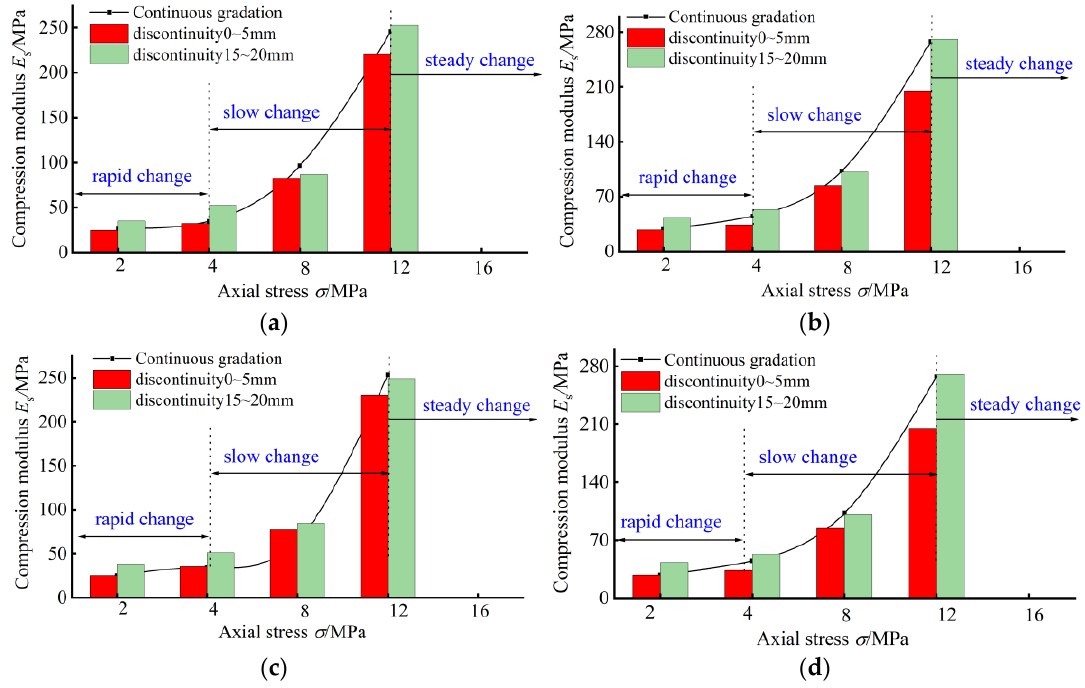
Figure 6. Compressive modulus – axial stress relationship for different gradations. ( a ) n = 0.2 sets of samples; ( b ) n = 0.4 sets of samples; ( c ) n = 0.6 sets of samples; ( d ) n = 0.8 sets of samples.